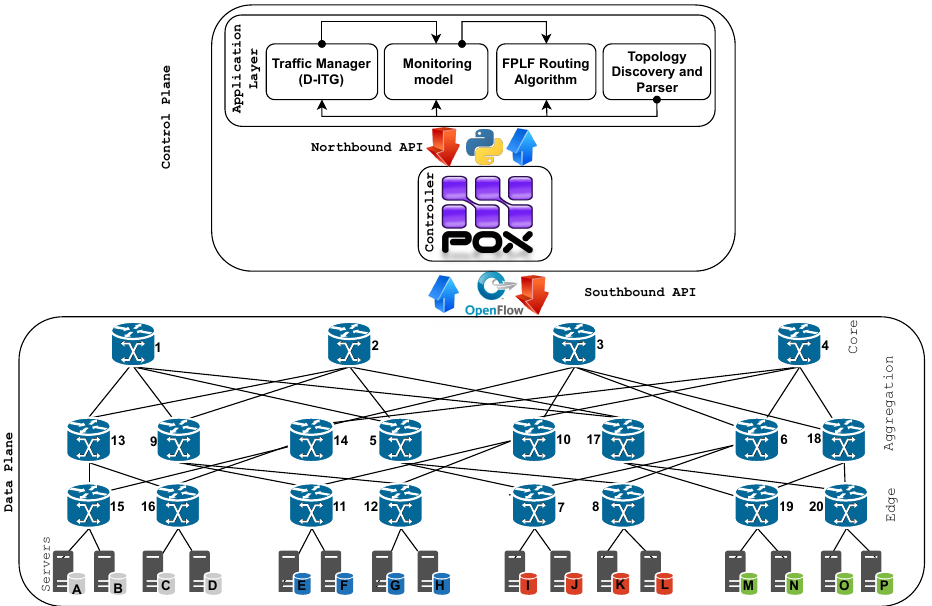
Figure 2. Architecture of the proposed framework and its components: the primary contribution is the FPLF algorithm and the traffic-aware optimizer blocks. OpenFlow was used on the southbound interface and POX Python APIs were used on the northbound